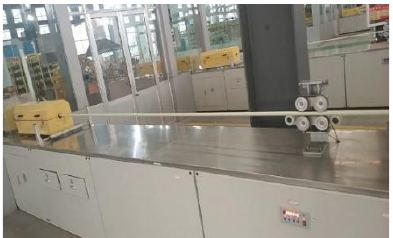
Figure 1. Manufacturing process of carbon fiber sucker rod.